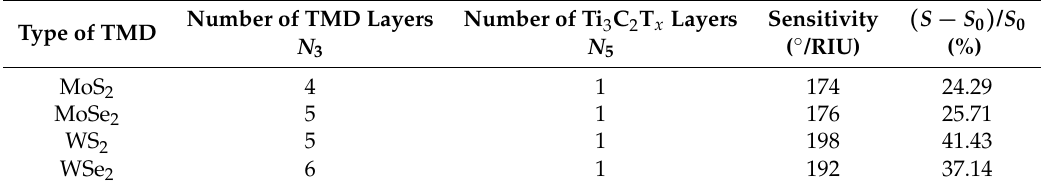
Table 1. Sensitivity and sensitivity enhancement at the optimized number of TMD layers and Ti 3 C 2 T x layers for the Ti 3 C 2 T x -TMDs-based SPR sensor.